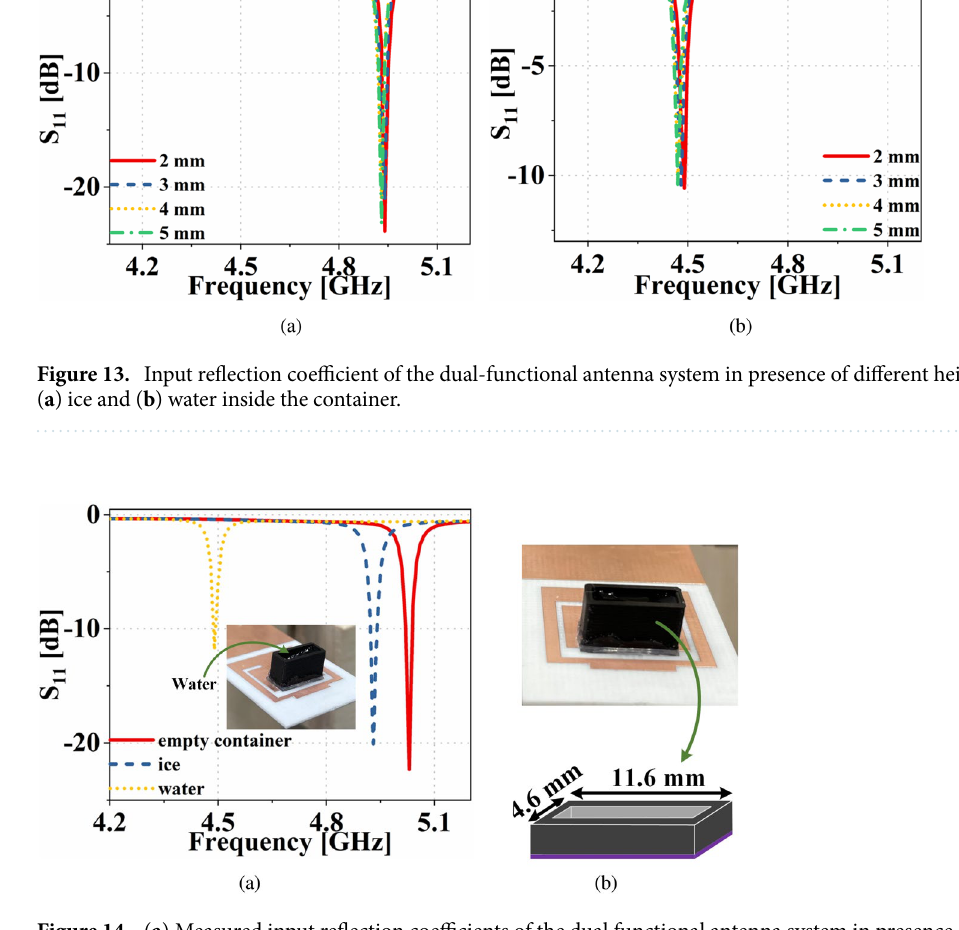
Figure 14. ( a ) Measured input reflection coefficients of the dual functional antenna system in presence of empty container, ice and water, ( b )